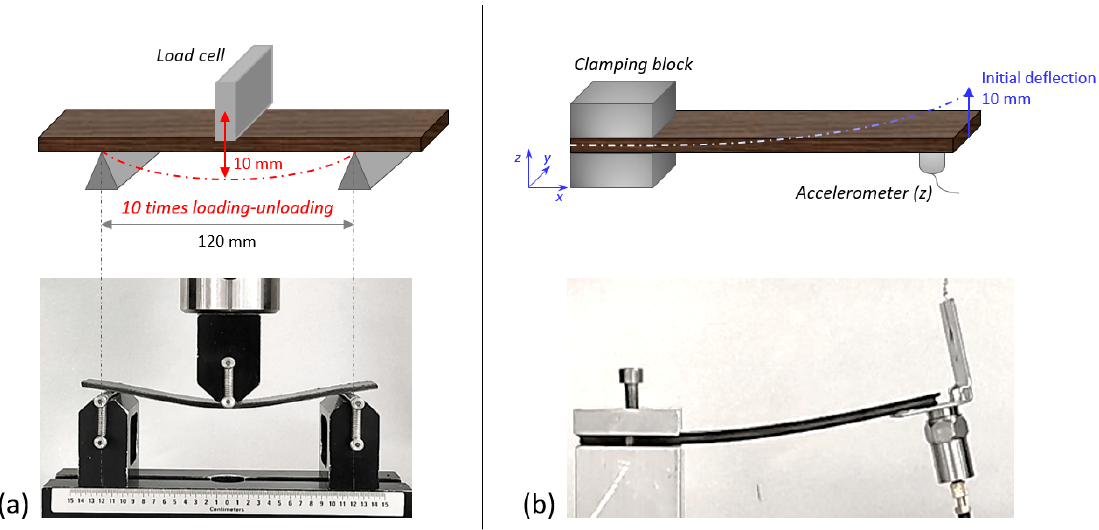
Figure 4. Testing setup details for quasi-static tests ( a ) and for dynamic free oscillation tests ( b ).